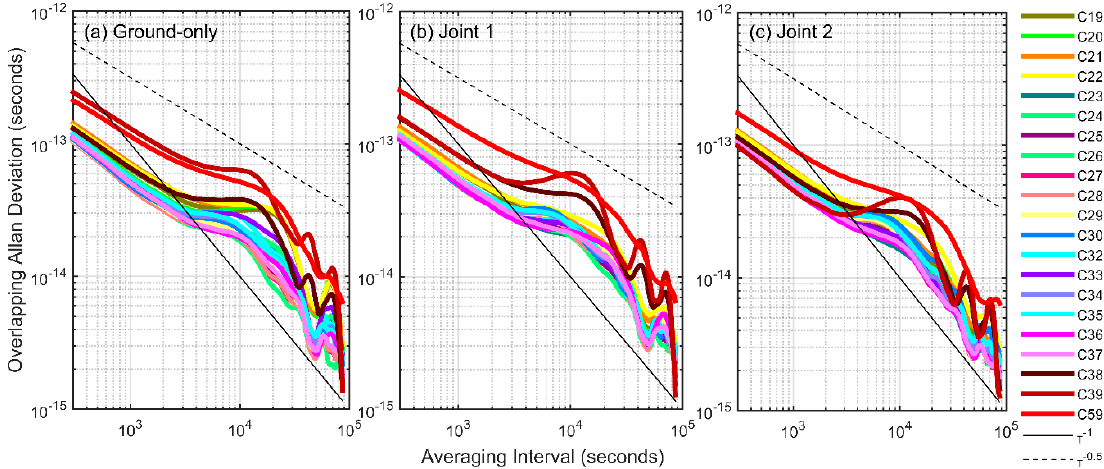
Figure 5. Overlapping Allan deviation of the satellite clock offsets estimated by: ground-only POD ( a ); Joint 1 POD ( b ); and Joint 2 POD ( c ).